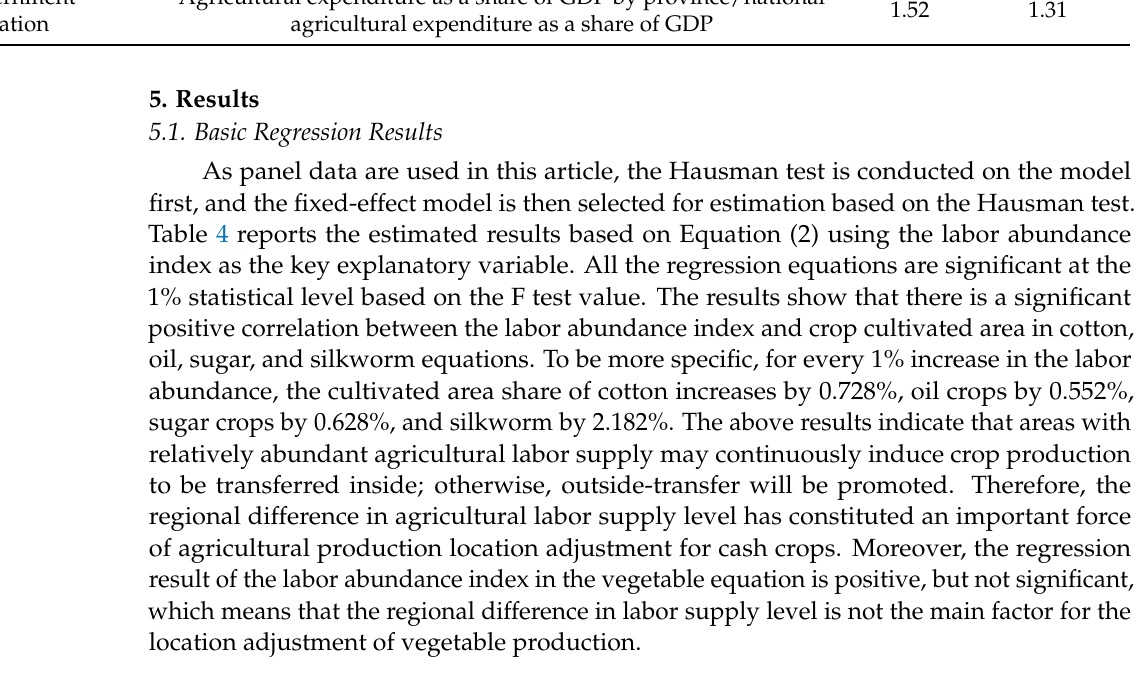
Table 4. The estimated results of regional differences in labor endowment on agricultural production location adjustment using labor abundance